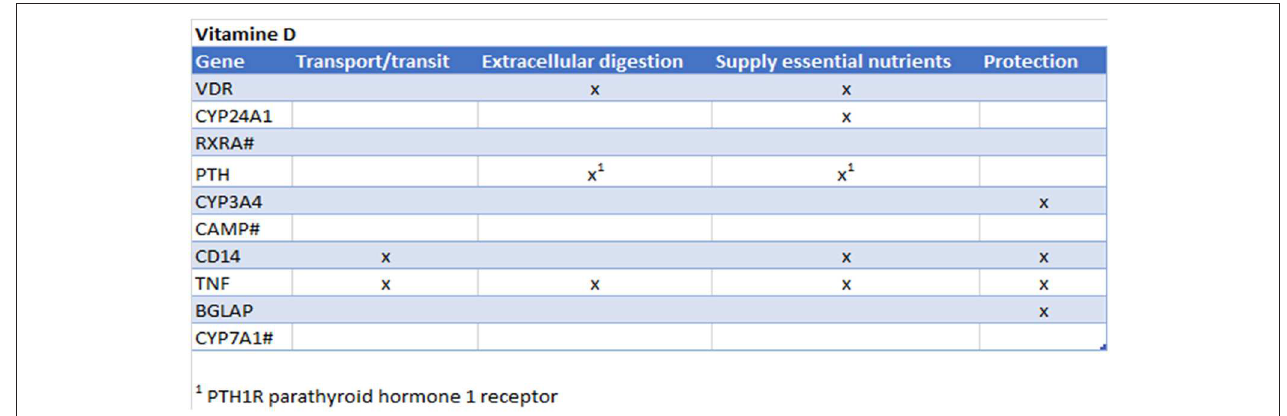
FIGURE 4 | Prediction from CTD vitamin D. Gene names are listed of the top 10 interacting genes per chemical. Crosses (x) indicate in which of the four gut functions they are involved. # Gene not found in all gut